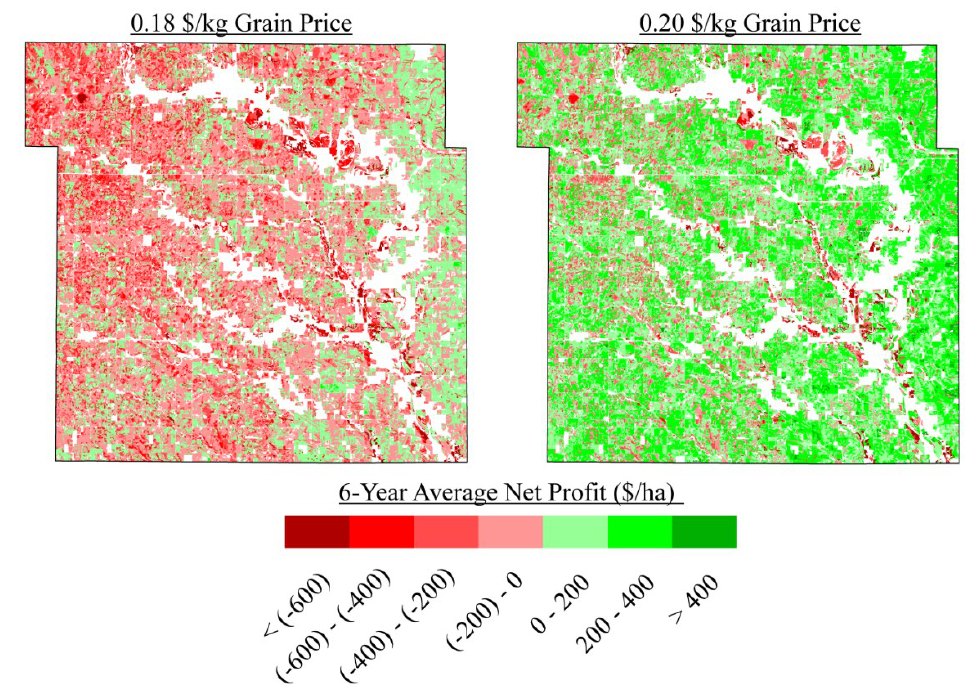
Figure 3. Dependence of six year average corn grain profits in Hardin County, Iowa based on grain prices of 0.18 $·kg −1 ( left ) and 0.20 $·kg −1 ( right ) resulting from the annually adjusted ISPAID corn yields and crop budget